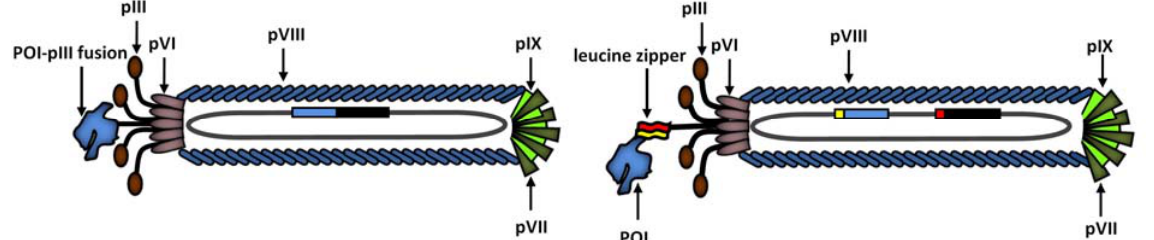
Figure 1. Schematic representation of bacteriophage M13 and different monovalent display types based on pIII coat protein. (left) Direct fusion of POI (protein of interest) to a truncated pIII. (right) Indirect fusion of POI to pIII by means of a leucine zipper